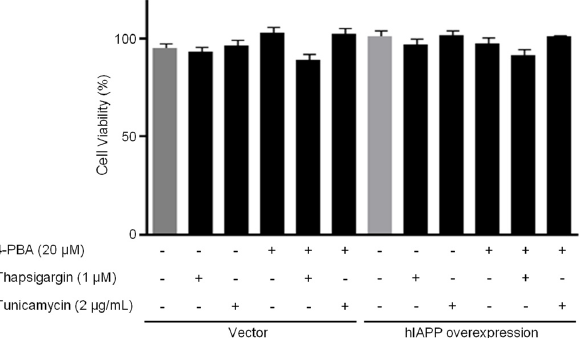
Figure 1. Cell viability in pCMV-Entry-expressing cells and INS1E-hIAPP-overexpressing cells under ER stress conditions. INS-1E cells were incubated in RPMI 1640 medium supplemented with 2% fetal bovine serum with/without thapsigargin (1 μ M) for 6 h or tunicamycin (2 μ g/mL) for 16 h and/or with/without 4-PBA (20 μ M) at 37 °C with 5% CO 2 . Cell viability was analyzed by Cell Counting Kit-8. Values are presented as the mean ± SEM of three experiments.